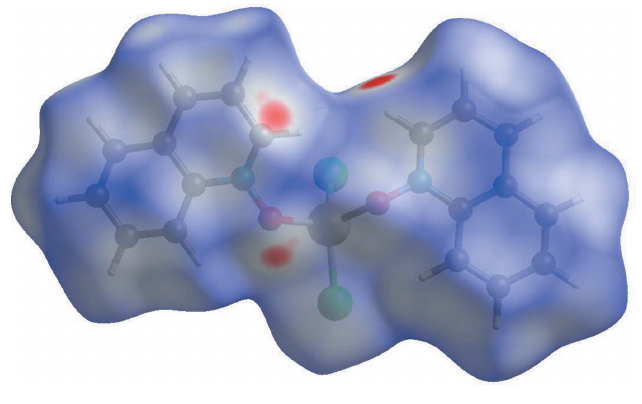
Figure 8 Hirshfeld surface for ( I ) mapped over d norm .